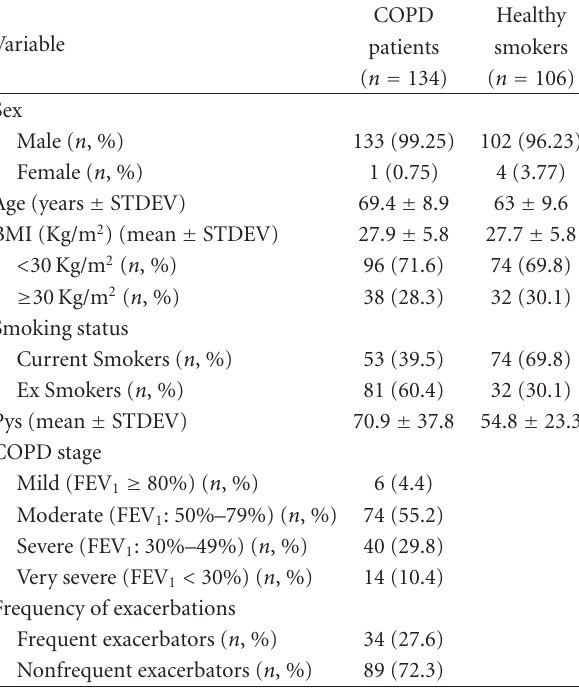
Table 1: Clinical and demographic data of study population.